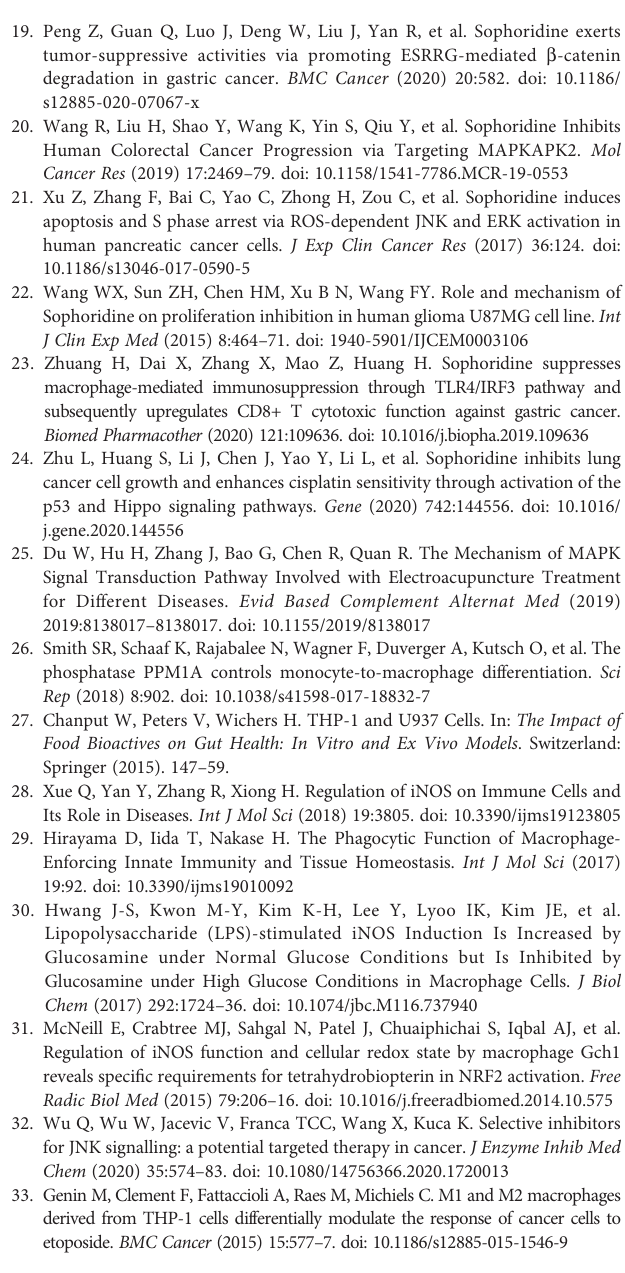
Supplementary Figure 1 | SP600125 inhibited the expression of pJNK and JNK in macrophages. Supplementary Figure 2 | Sophoridine inhibited the growth of lung cancer cells in dose-dependent manners. Supplementary Figure 3 | Sophoridine suppressed M2 polarisation of macrophages in vitro